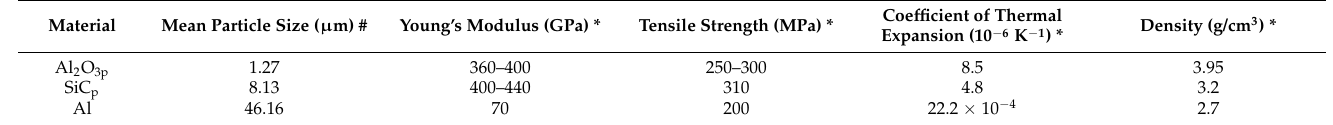
Table 1. Properties of the consumables (#: measured at particle level, *: measured at sample level after sintering).